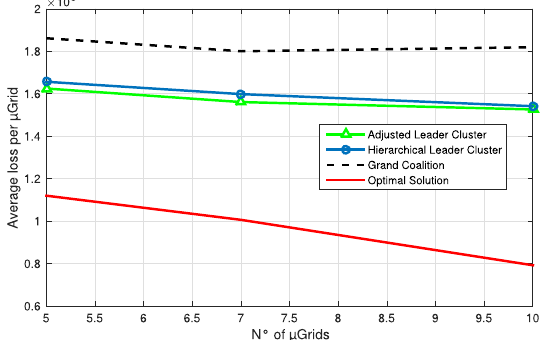
Fig. 7 Average loss per μ grid